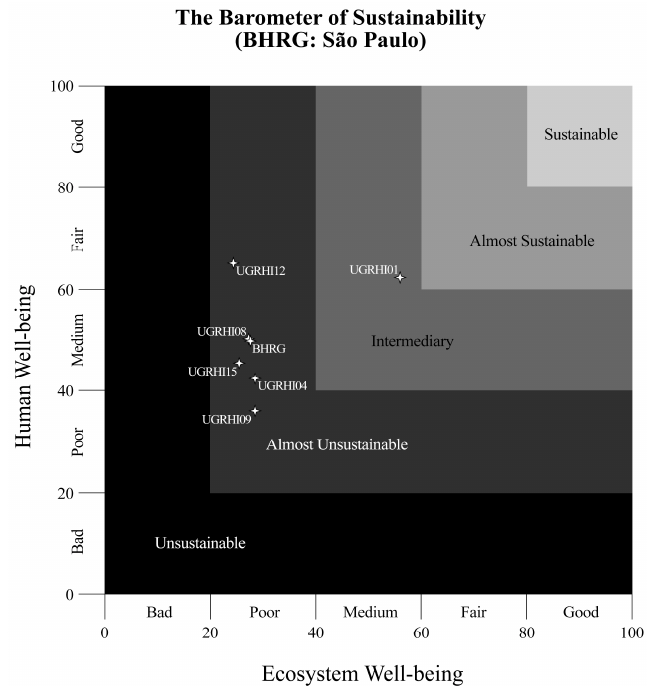
Figure 5. Two-dimensional graphs representing water sustainability condition at BHRG and its respective water management units in São Paulo.